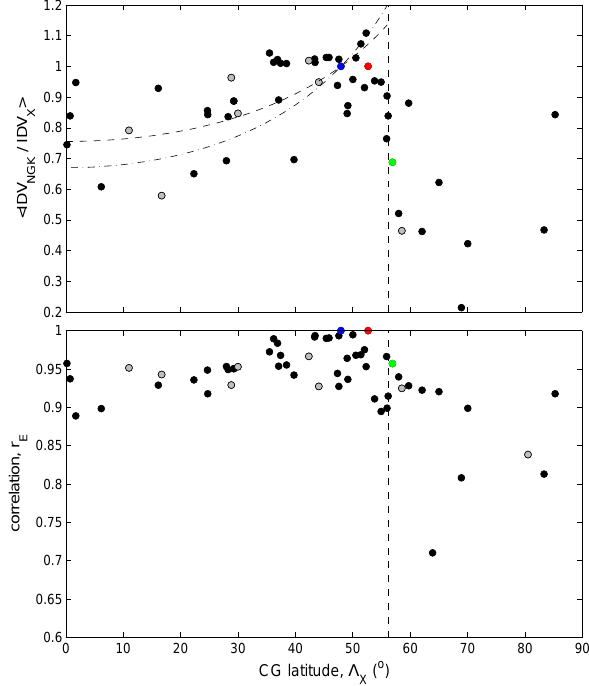
Fig. 5. Analysis of IDV variations with station corrected geomag- netic latitude in the same format as Fig. 4. (Top) the ratio f X = <IDV NGK /IDV X >; (bottom) the correlation with Eskdalemuir data, r E